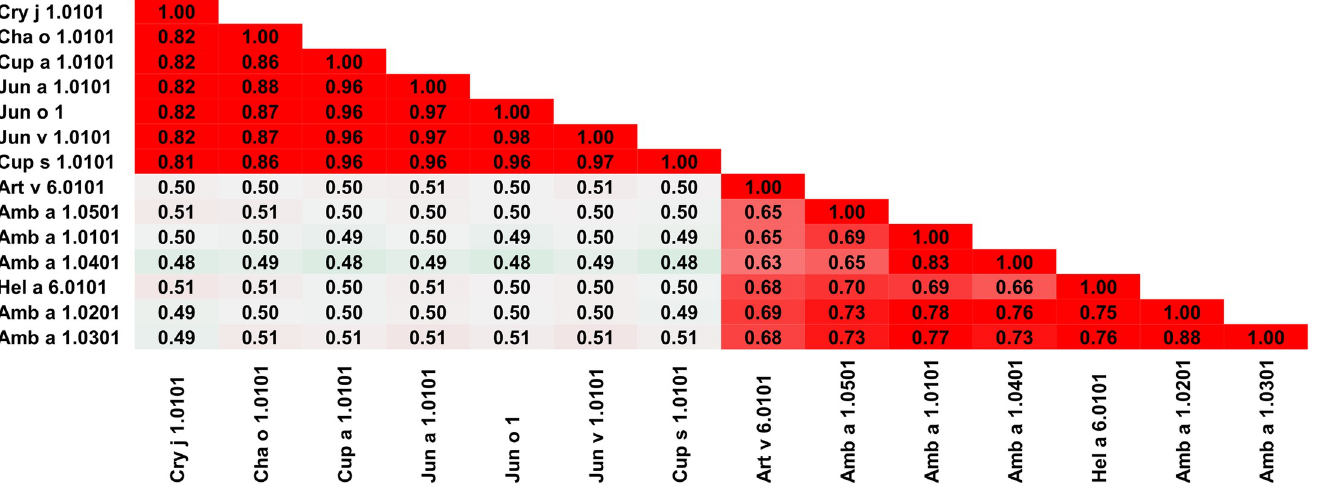
PLOS ONE | https://doi.org/10.1371/journal.pone.0208276 November29,